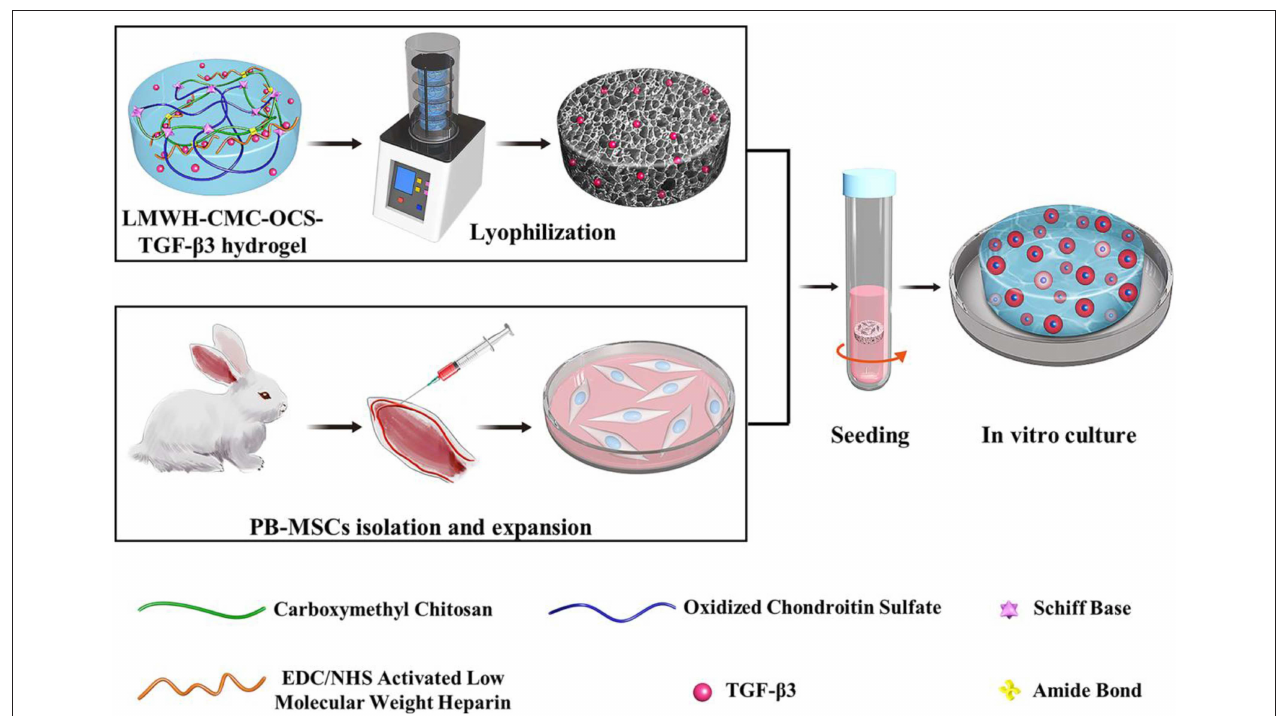
FIGURE 1 | Schematic illustration of LMWH-CMC-OCS-TGF- β 3 hydrogel as matrix of PBMSCs for constructing tissue-engineered cartilage in vitro